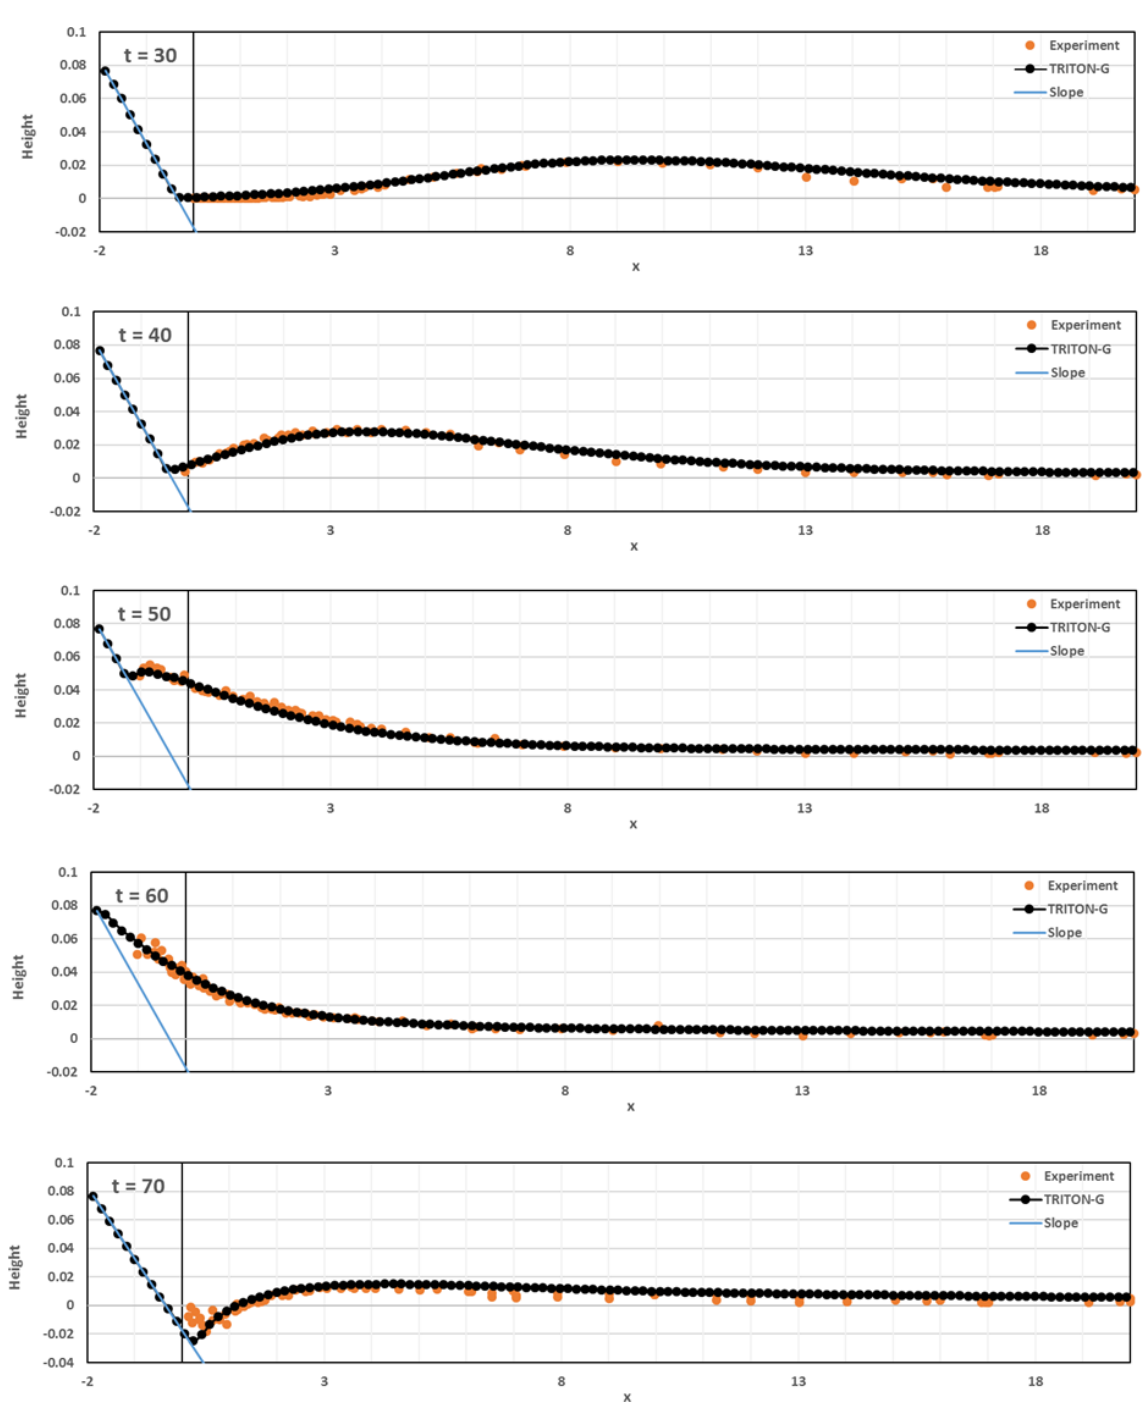
Figure A2. Comparison of numerically calculated free surface profile at different dimensionless times for the non-breaking case H/d = 0 .